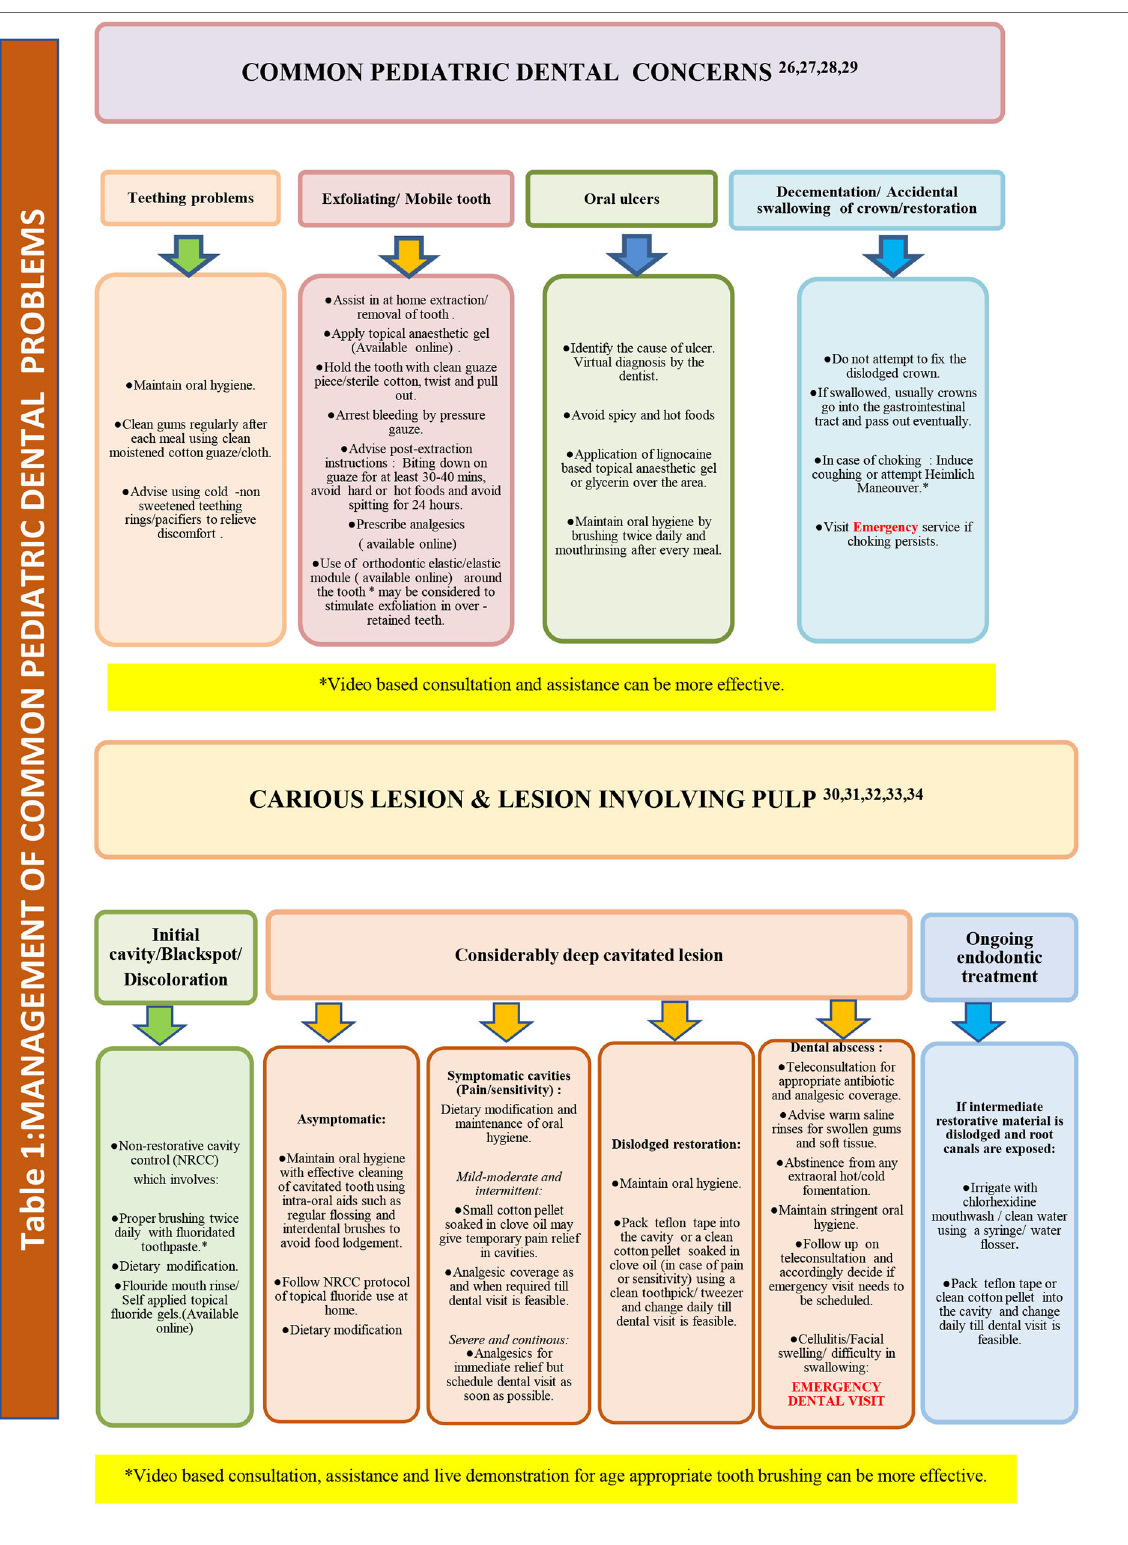
TABLE 1 | Management of common pediatric dental